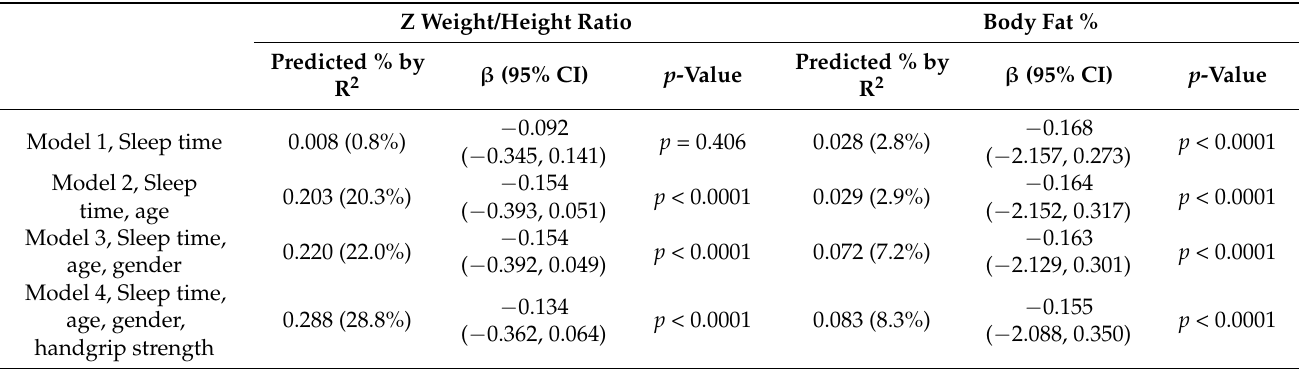
Table 2. Association between sleep duration with different anthropometric (z-weight/height) and body composition (body fat percentage) outcomes in Latin American Chilean